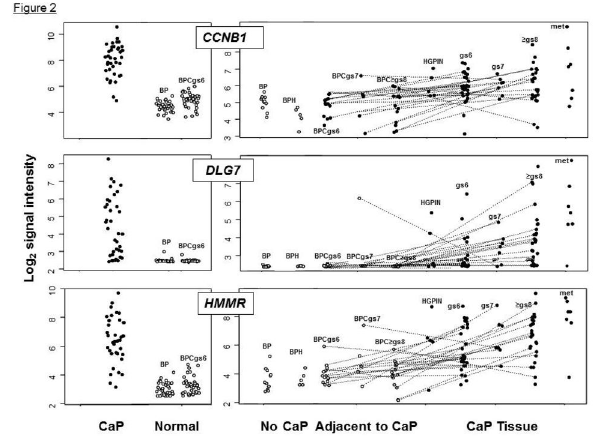
Figure 2. Transcript levels for CCNB1, DLG7, and HMMR measured in CaP and noncancerous prostate tissue. Panels on the left compare transcript levels in CaP bulk tissue (full symbols) with the levels measured in benign prostate tissue (open symbols) from men free of CaP (BP) and in benign prostate tissue (BPC) adjacent to CaP of combined Gleason score 6 (gs6). Panels on the right display transcript levels measured in non-neoplastic prostate epithelial cells isolated by laser capture microdissection (LCM) in benign tissues (open symbols): BP, benign prostatic hyperplasia (BPH) and BPC adjacent to CaP of the indicated Gleason score (gs). Full symbols in panels on the right denote transcript levels measured in LCM-isolated CaP cells: high-grade prostatic intraepithelial neoplasia (HGPIN), the cells isolated from areas of combined Gleason scores 6 through 8 and cells isolated from lymph node metastases (met). CCNB1, cyclin B1; DLG7, discs large homolog 7; HMMR, hyaluronan-mediated motility receptor.